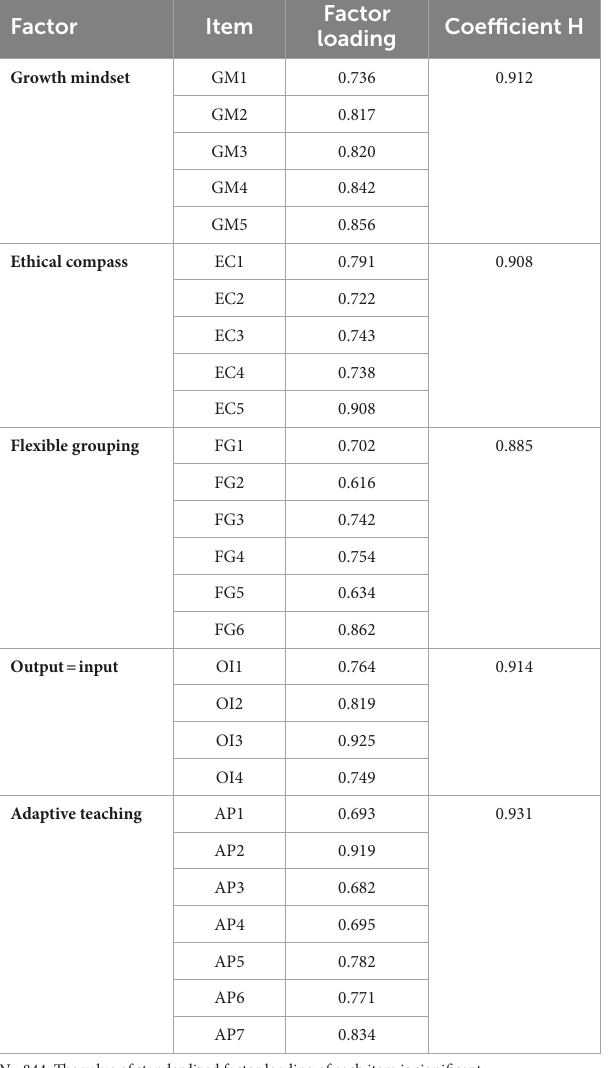
TABLE 4 Standardized factor loading and scale reliability.